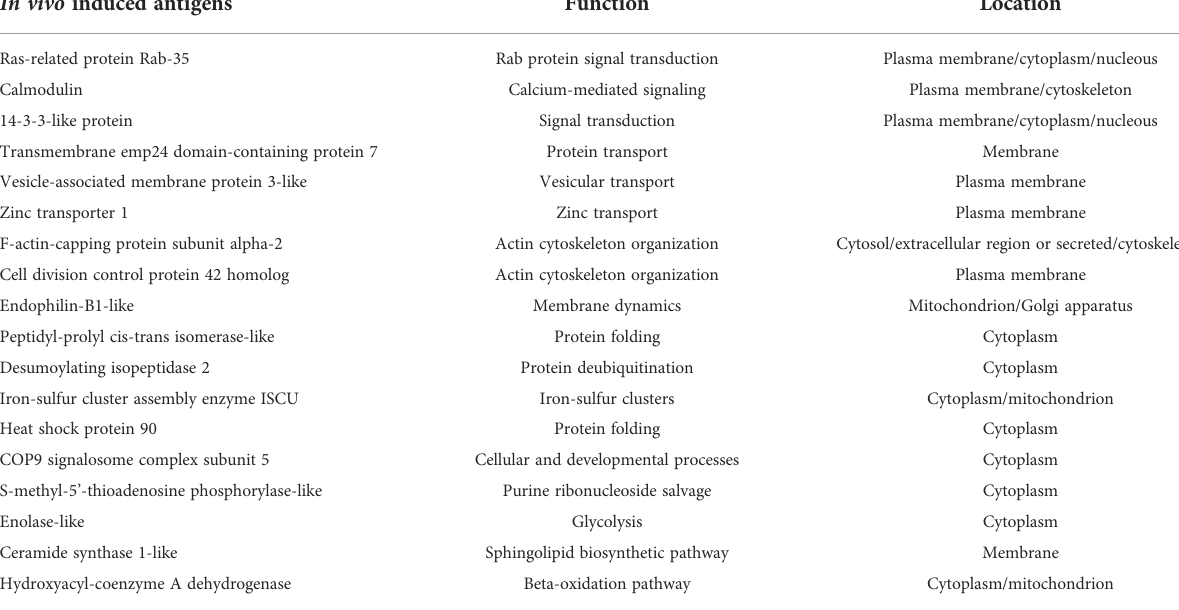
TABLE 1 Identi fi ed antigenic genes of Tetracapsuloides bryosalmonae